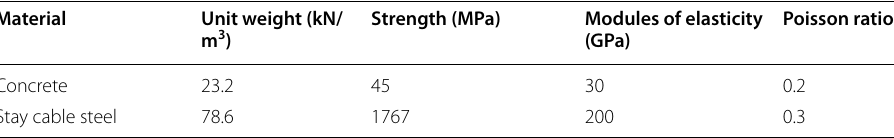
Table 1 Material properties of concrete and stay cables steel of the bridge Material